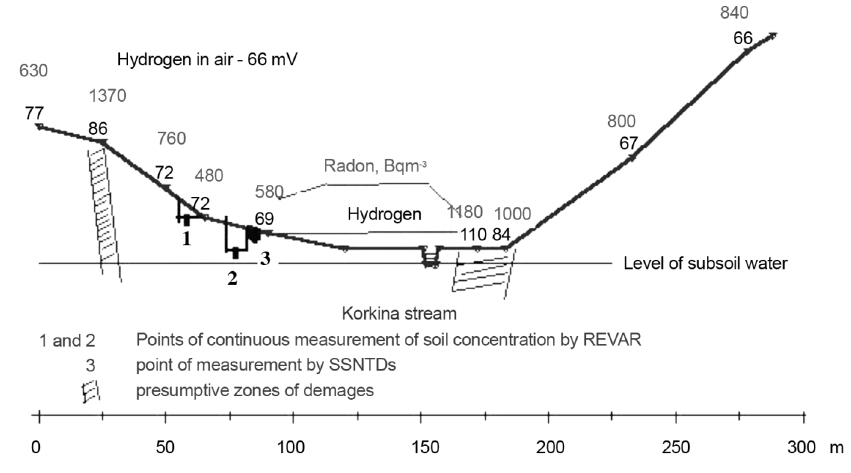
Fig. 2. Schematic structural map of the PRT station’s area and results of radon-hydrogen measurements across the valley of Korkina